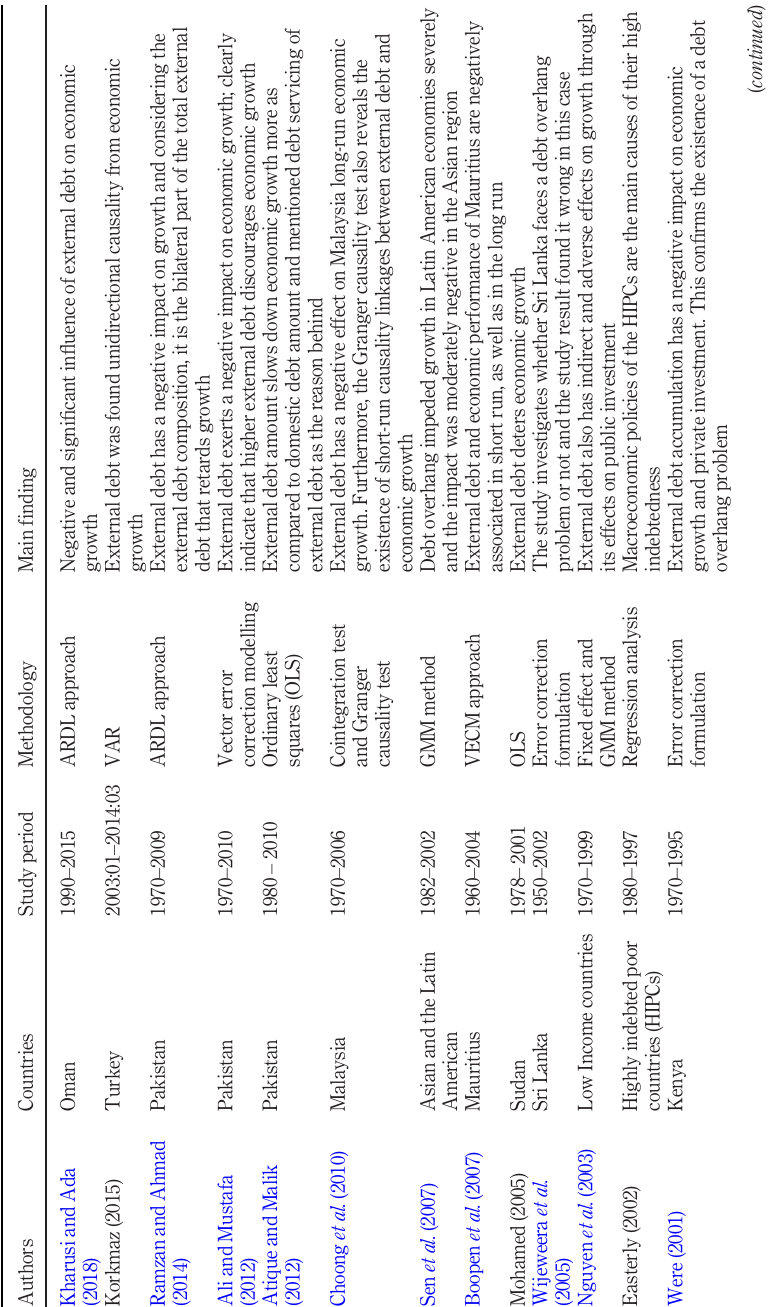
Table 1. Summary of selected empirical studies on external